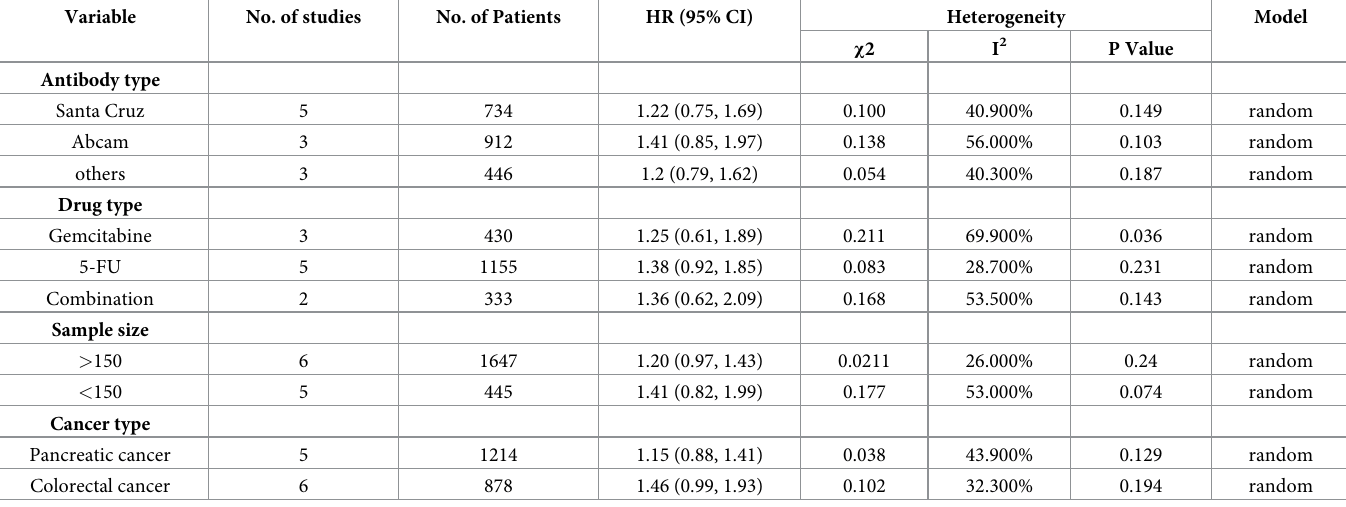
Table 3. Stratified analysis of pooled HRs for cancer patients in different subgroups.